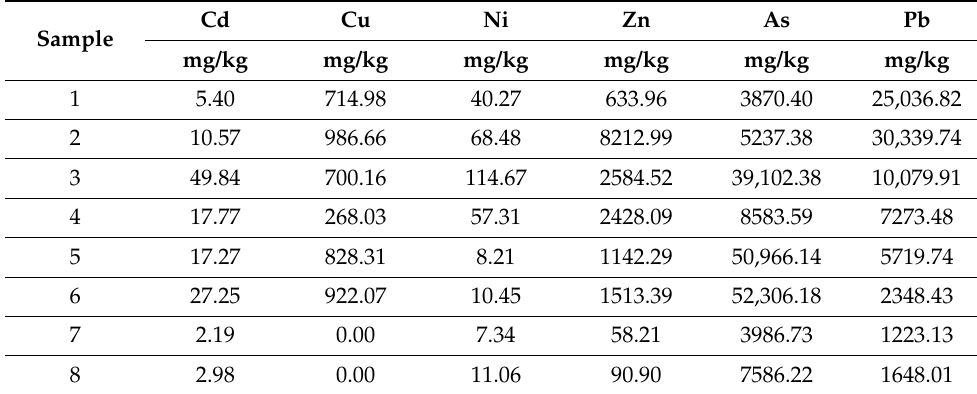
Table 7. Chemical composition of soil